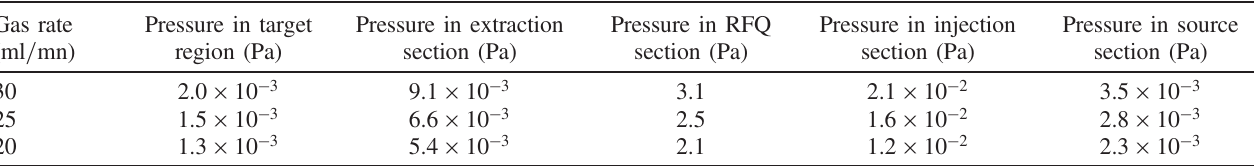
TABLE I. Pressure measurements inside SHIRaC beam line sections: the source section, the injection section, the RFQ chamber, the extraction section and the target